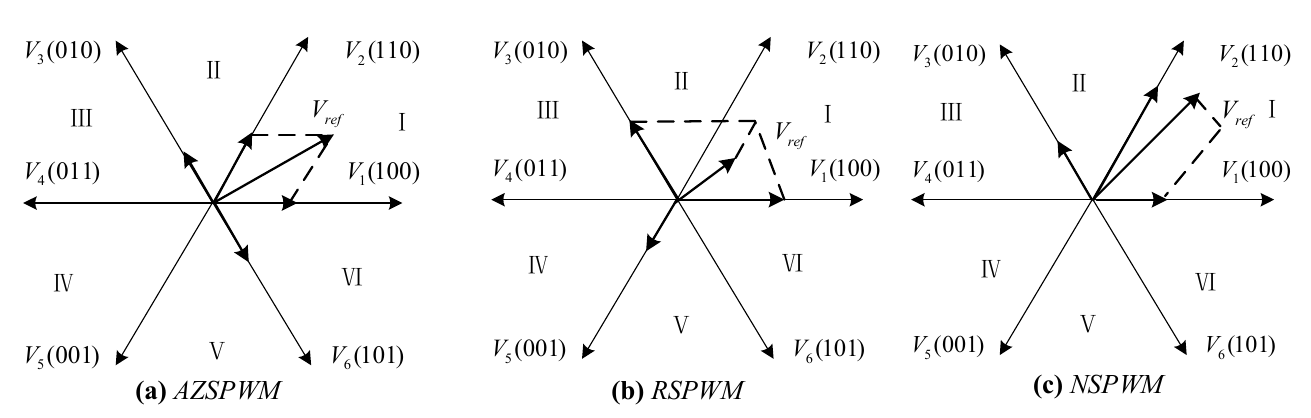
Figure 4. Reduced Common ‐ Mode Voltage PWM.